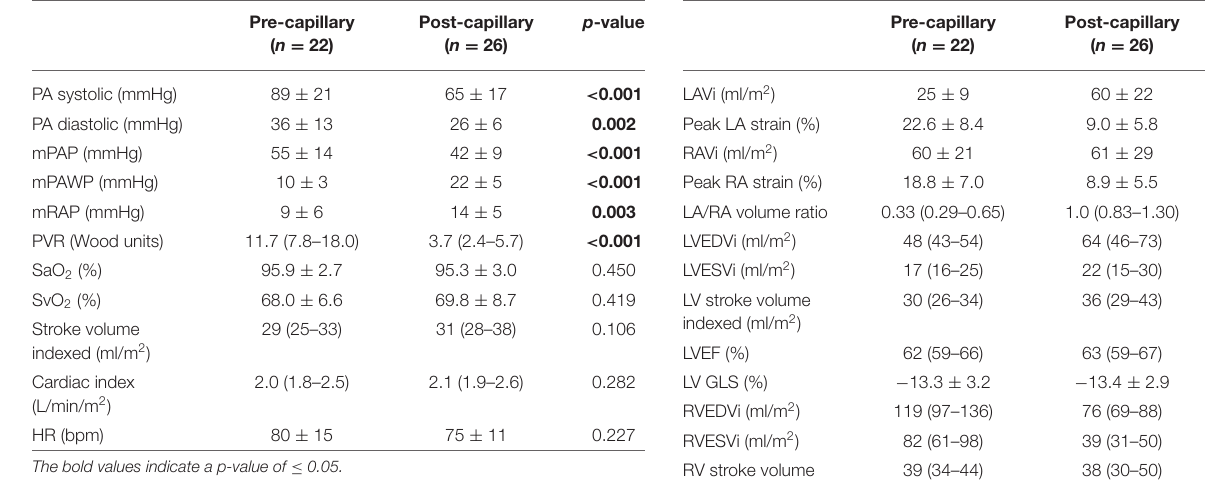
TABLE 2 | Invasive haemodynamic parameters.